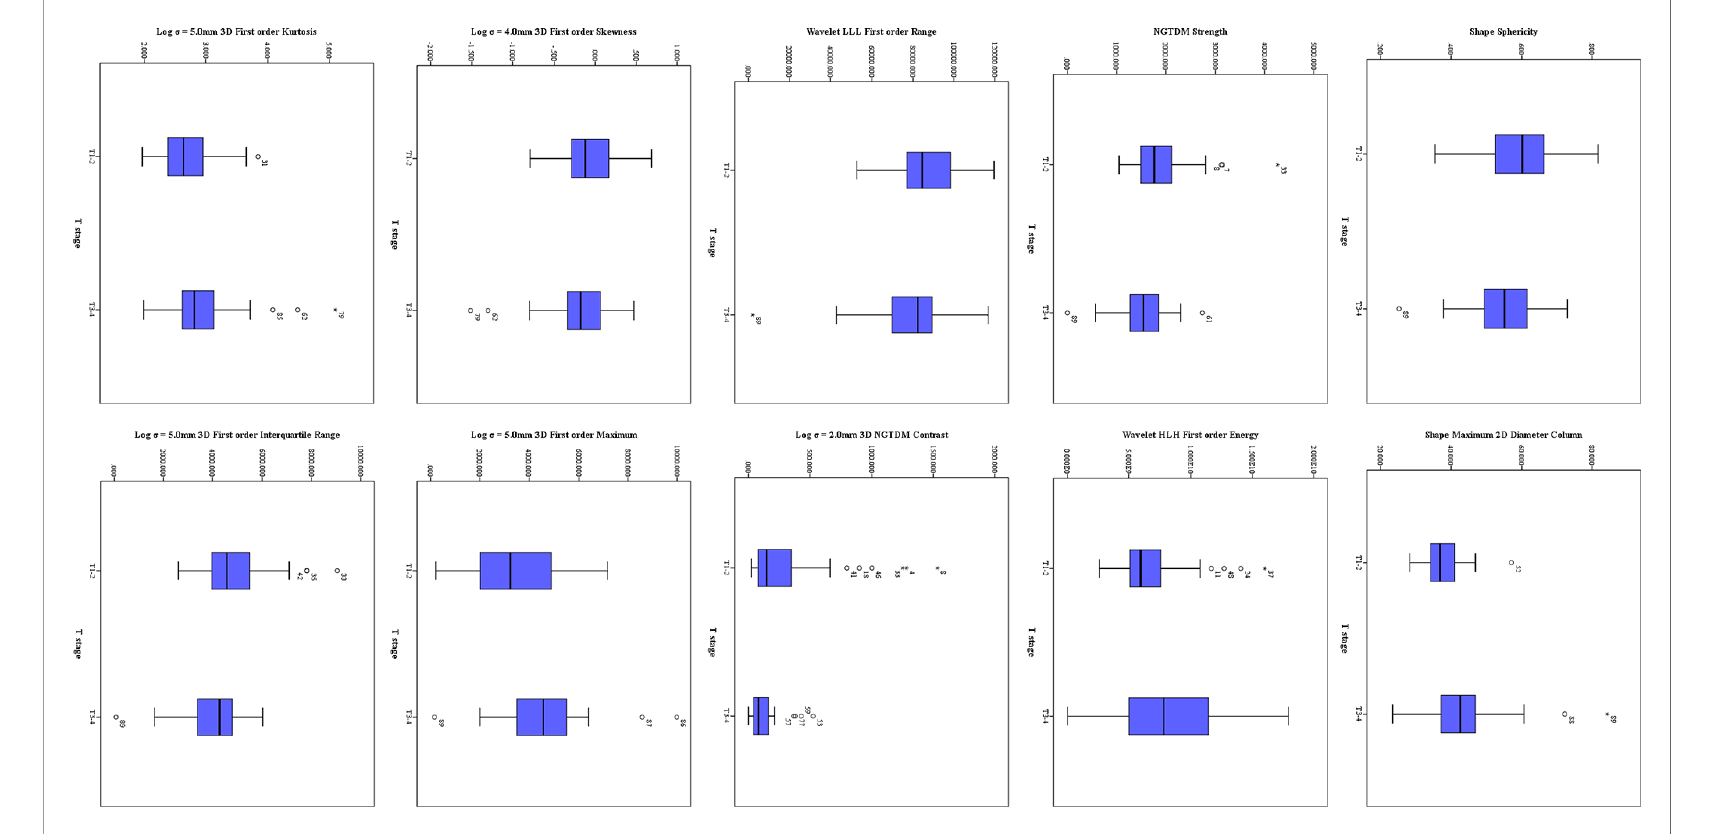
FIGURE 4 | The distribution of signi fi cant features derived from ADC maps. The symbol ( “ * ” ) represents the extreme